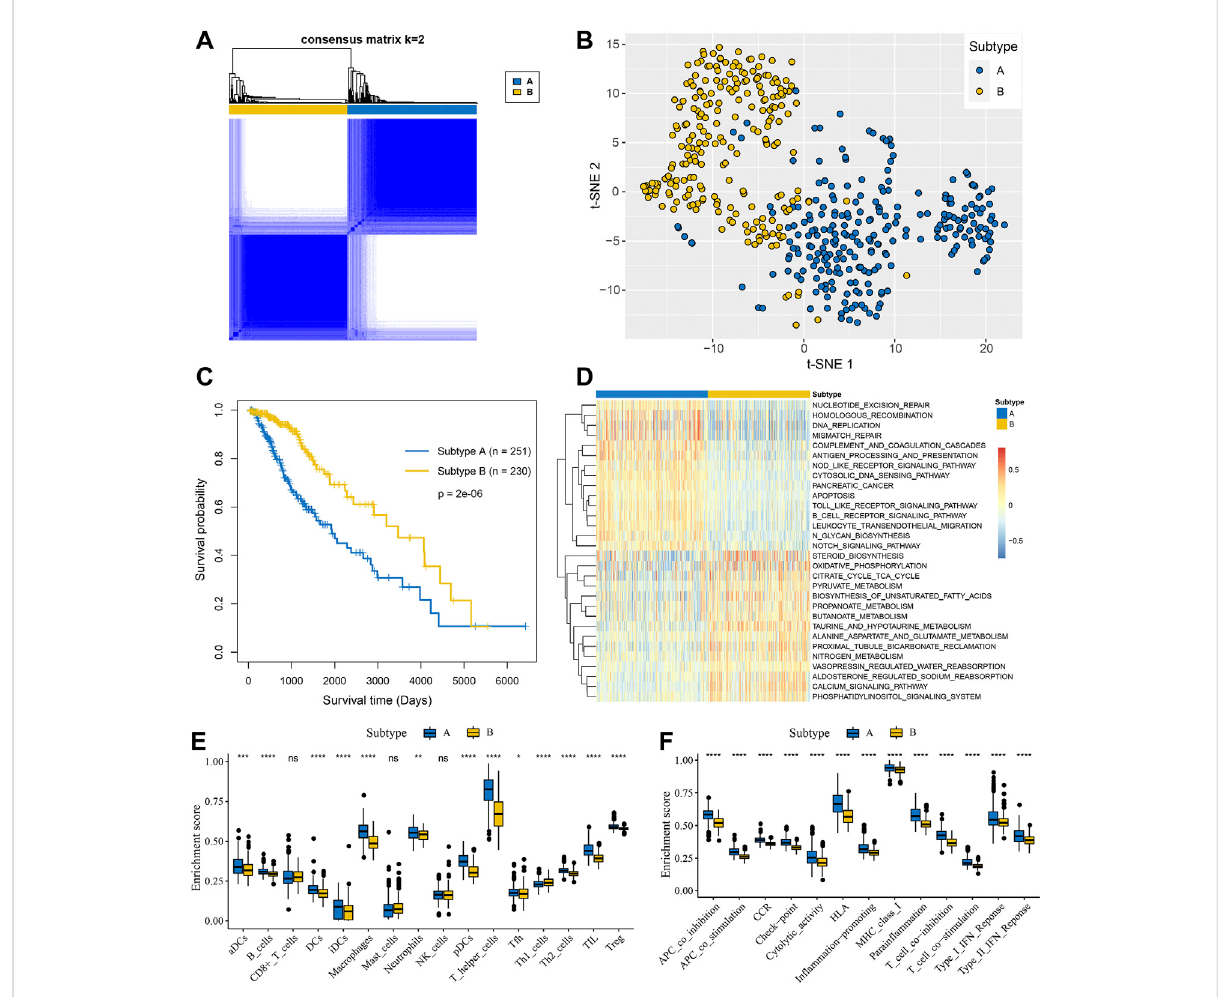
FIGURE 1 Glycosylation-related molecular subtypes with distinct survival and immune microenvironment features in LGGs. (A) Consensus clustering matrix of 481 samples from the TCGA dataset for k = 2. (B) t-SNE of the expression pro fi les of glycosyltransferase family genes in the TCGA cohort con fi rmed the subtypes. (C) K-M analysis for the subtypes of LGGs patients. (D) GSVA enrichment analysis displayed the differences of KEGG pathways between the two subtypes. Red represented higher pathway activity and blue represented lower pathway activity. The boxplots visualized the ssGSEA enrichment scores of immune in fi ltrating cells (E) and immune functions (F) between